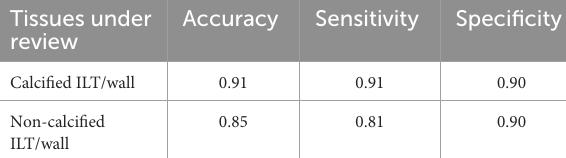
TABLE 2 Measured accuracy, sensitivity, and specificity for the classification of calcified vs. non-calcified ILT/wall. Tissues under